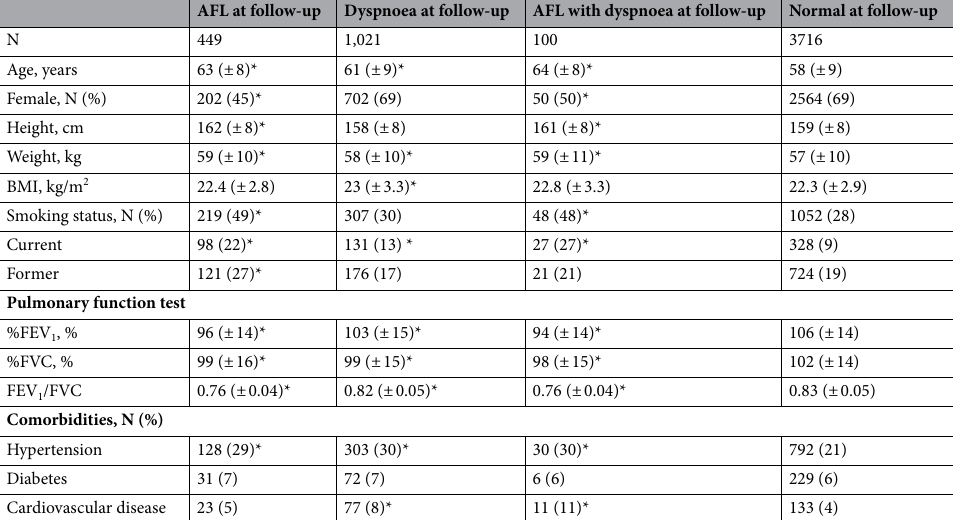
Table 2. Characteristics at enrolment of subjects who had AFL, dyspnoea or both at follow-up (N = 5086). All values are expressed as the mean (± SD) except categorical variables, which are expressed as N (%).